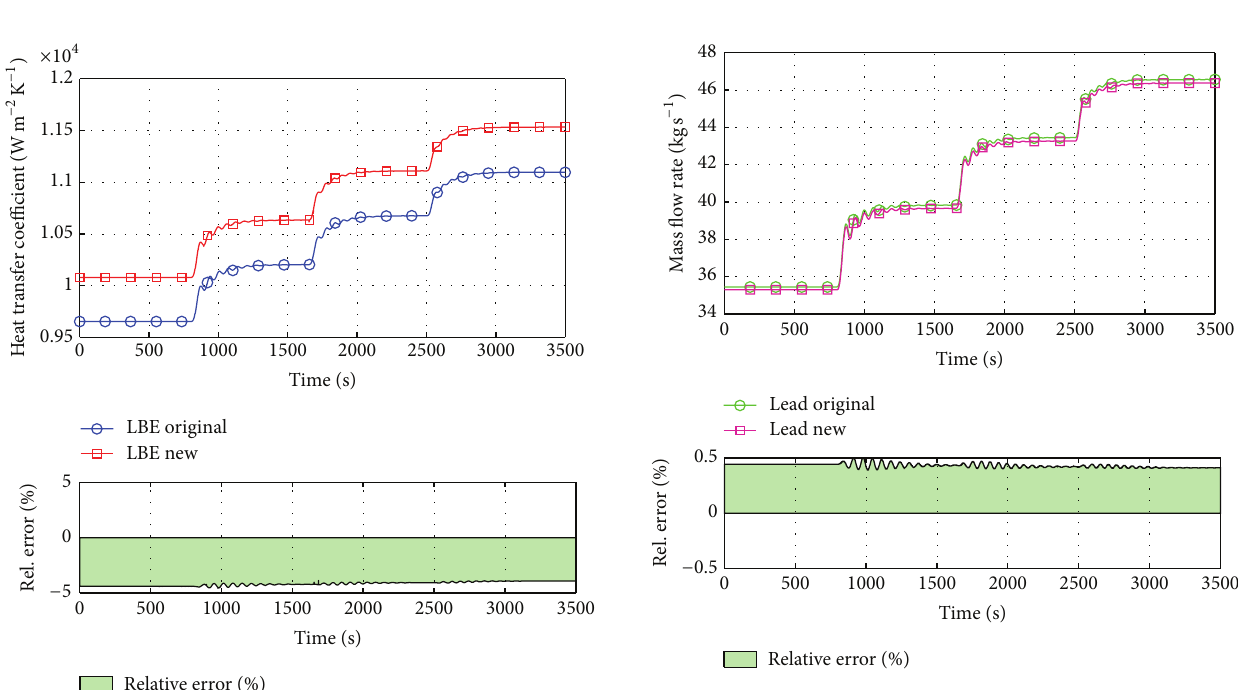
Figure 27: Lead system mass flow rate, original versus new “tpf” file.